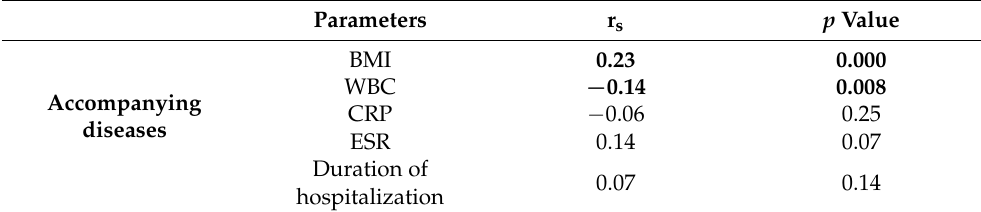
Table 6. Correlations between number of accompanying diseases and BMI, WBC, CRP, ESR, and duration of hospitalization. The strength of the correlations was determined using Spearman’s rank correlation coefficient; p < 0.05 was considered statistically